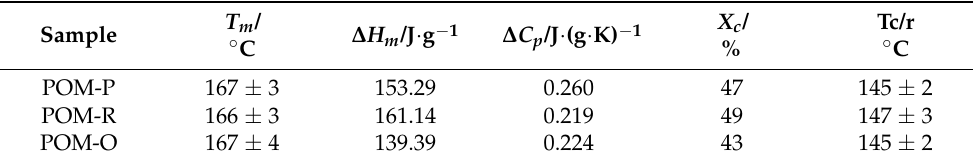
Table 3. Melting temperature ( T m ), enthalpy of fusion ( ∆ H m ), changes in specific heat ( ∆ c p ), the degree of crystallinity ( X c ), and temperature of crystallization ( T cr